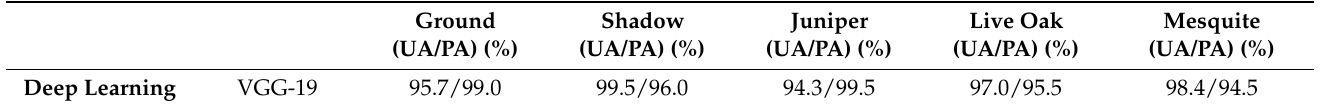
Table 5. User and producer accuracies for the traditional and machine learning